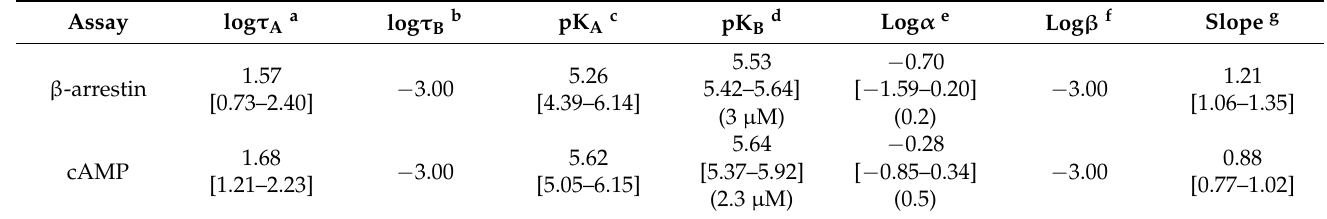
Table 4. Functional parameters for ONC201 antagonism of D 2 R-mediated signaling. Data are the best fit of grouped data from at least 3 independent experiments, expressed as geometric means [95% confidence interval]. a The logarithm of dopamine efficacy; b the logarithm of ONC201 efficacy constrained to − 3 to indicate ONC201 displays no detectable agonist efficacy; c the negative logarithm of dopamine affinity; d the negative logarithm of ONC201 affinity; e the logarithm of the binding cooperativity between dopamine and ONC201; f the logarithm of the magnitude of the allosteric effect of the modulator on the efficacy of the orthosteric agonist, constrained to − 3 indicating that ONC201 exhibits a very high level of negative cooperativity; g the Hill slope